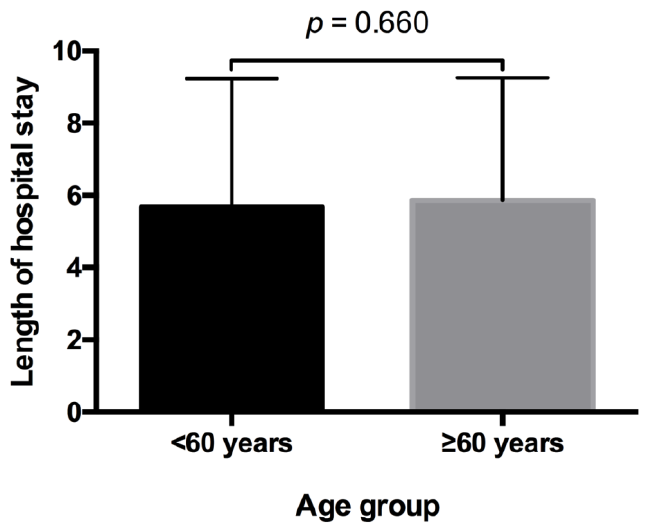
Figure 3. Comparison of groups for postoperative length of stay. The mean duration of stay after the procedure was 5.00 days for both groups (SD ± 3.55 in patients < 60 years; SD ± 3.40 in patients ≥ 60 years). p -value corresponding to testing for differences between groups with Mann–Whitney test ( p = 0.660).